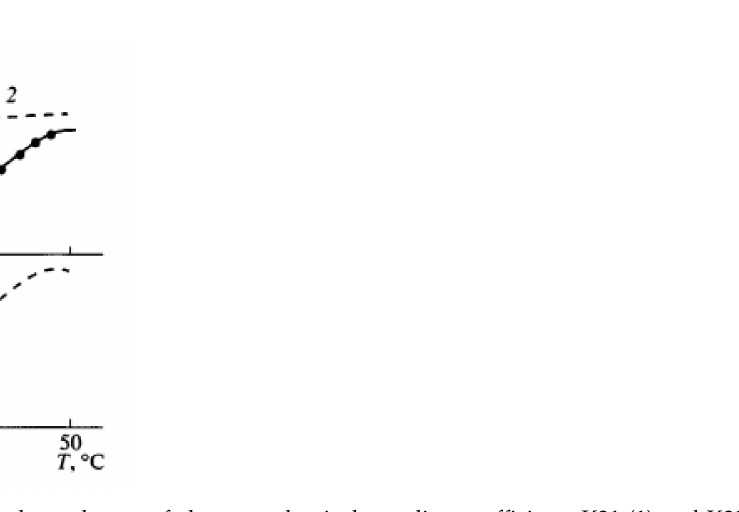
Figure 14. Temperature dependences of electromechanical coupling coefficients K31 (1) and K33 (2) [117] and Poisson’s ratio µ 31 (3) for an oriented PVDF film [118]. Reprinted/adapted with permission from Ref. [XX]. Reprinted/adapted with permission from Ref. [118]. 2022, Elsevier”.